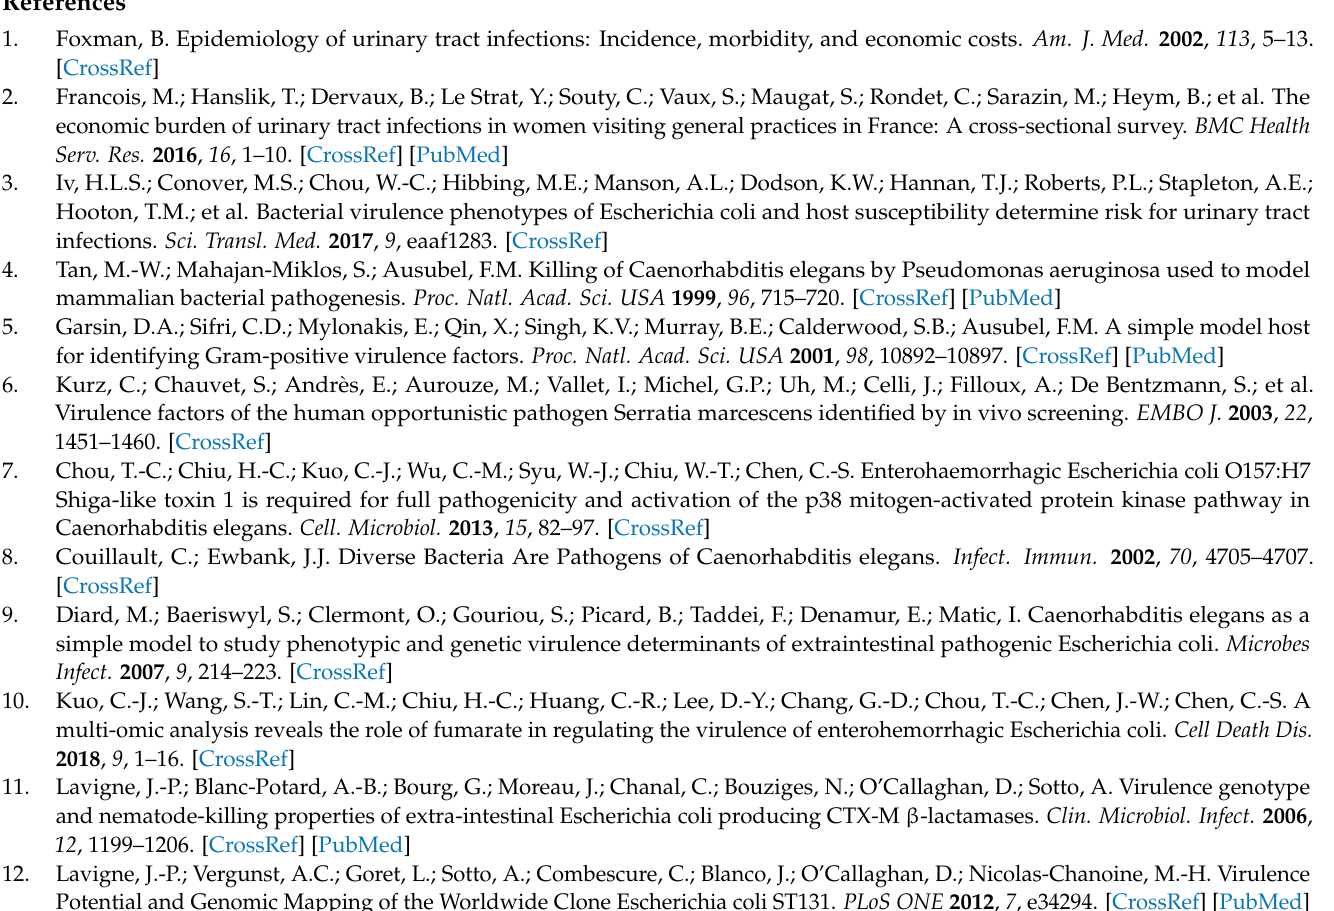
phylogenetic groups, Figure S2: The number of virulence factors in clinically isolated E. coli , Table S1: Primers used in this study, Table S2: E. coli strains used for the solid pathogenic assay, Table S3: Symptoms of clinically isolated 133 E. coli